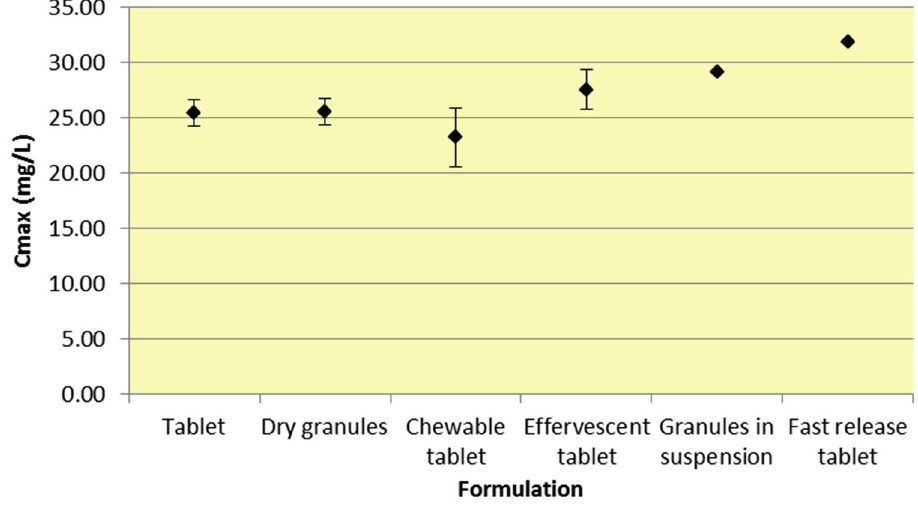
Figure 4. Summary SA C max for various 500 mg formulations (Mean ±